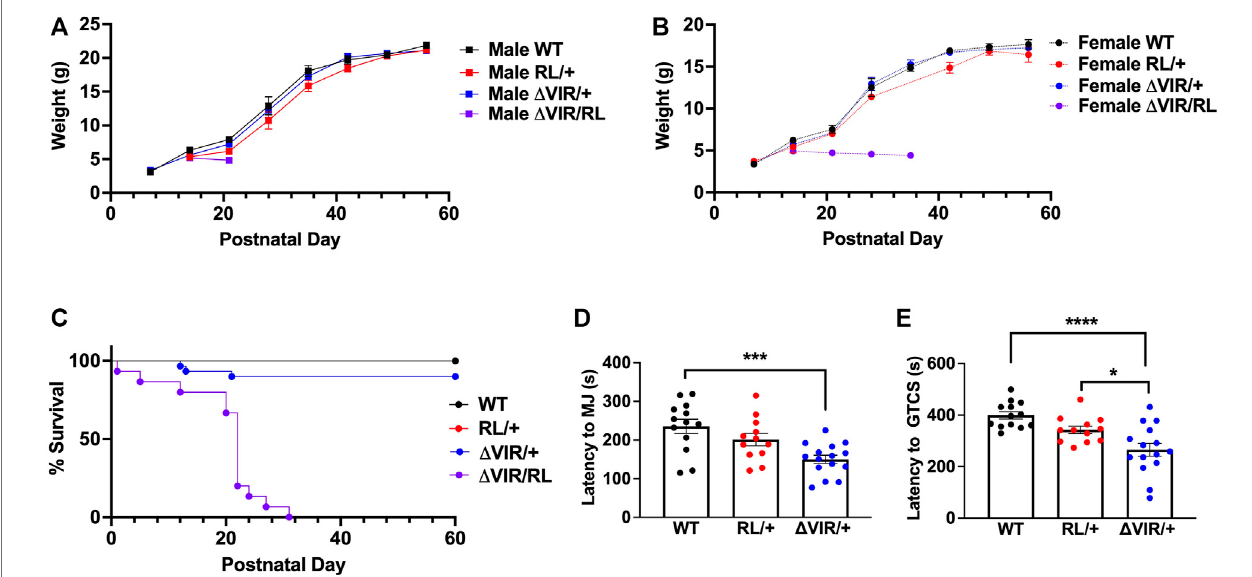
FIGURE5| Generationandcharacterization of Δ VIR/RLbiallelicheterozygousmice. (A,B) Δ VIR/RLmutantsweighedlessthansame-sexlittermatesfromP12. (C) Maleandfemale Δ VIR/RLmutantsexhibitedamaximumlifespanof22and31 days,respectively.Only3/22 Δ VIR/+mutantsdiedprematurely.Log-rankMantelCoxtest. (A-C) WTmale N (cid:1) 12;WTfemale N (cid:1) 10;RL/+male N (cid:1) 12;RL/+female N (cid:1) 3; Δ VIR/+male N (cid:1) 16; Δ VIR/+female N (cid:1) 14; Δ VIR/RLmale N (cid:1) 7; Δ VIR/RLfemale N (cid:1) 8. (D) Compared to WT littermates, Δ VIR/+ mutants exhibited a signi fi cantly lower average latency to the fi rst MJ. (E) Δ VIR/+ mutants exhibit a signi fi cantly lower average latency to the fi rst GTCS compared to RL/+ mutants and WT littermates. (D,E) Kruskal-Wallis test followed by Dunn ’ s multiple comparisons. WT N (cid:1) 13; RL/+ N (cid:1) 12; Δ VIR/+ N (cid:1) 15. * p ≤ 0.05, *** p ≤ 0.001, **** p ≤